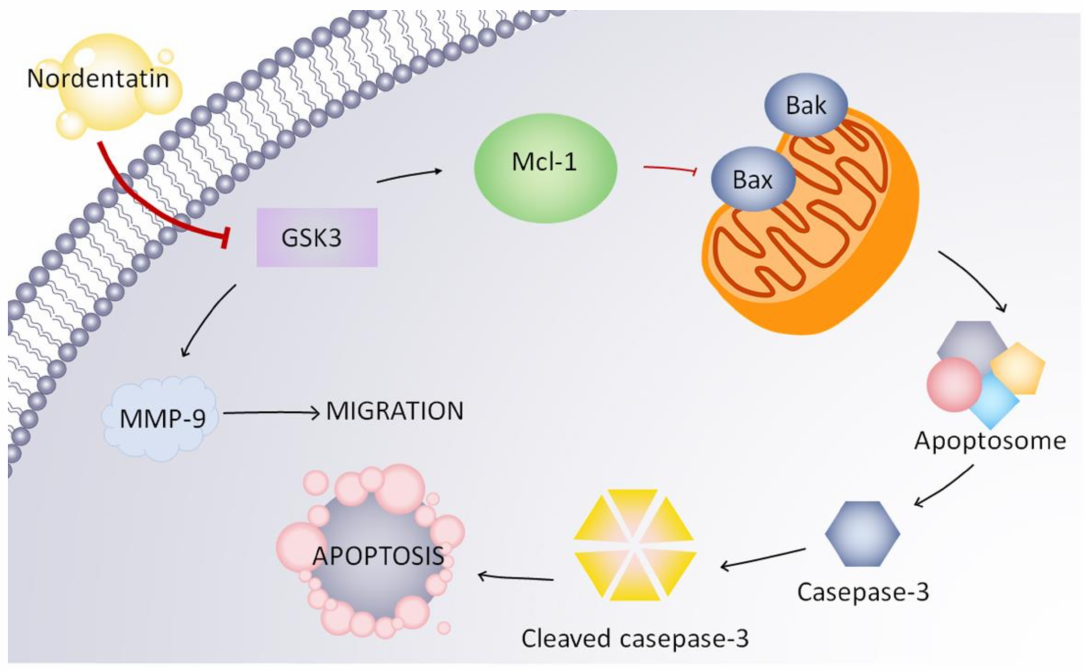
Figure 7. The effect of nordentatin on the GSK-3 pathway in the apoptosis and migration of SH- SY5Y